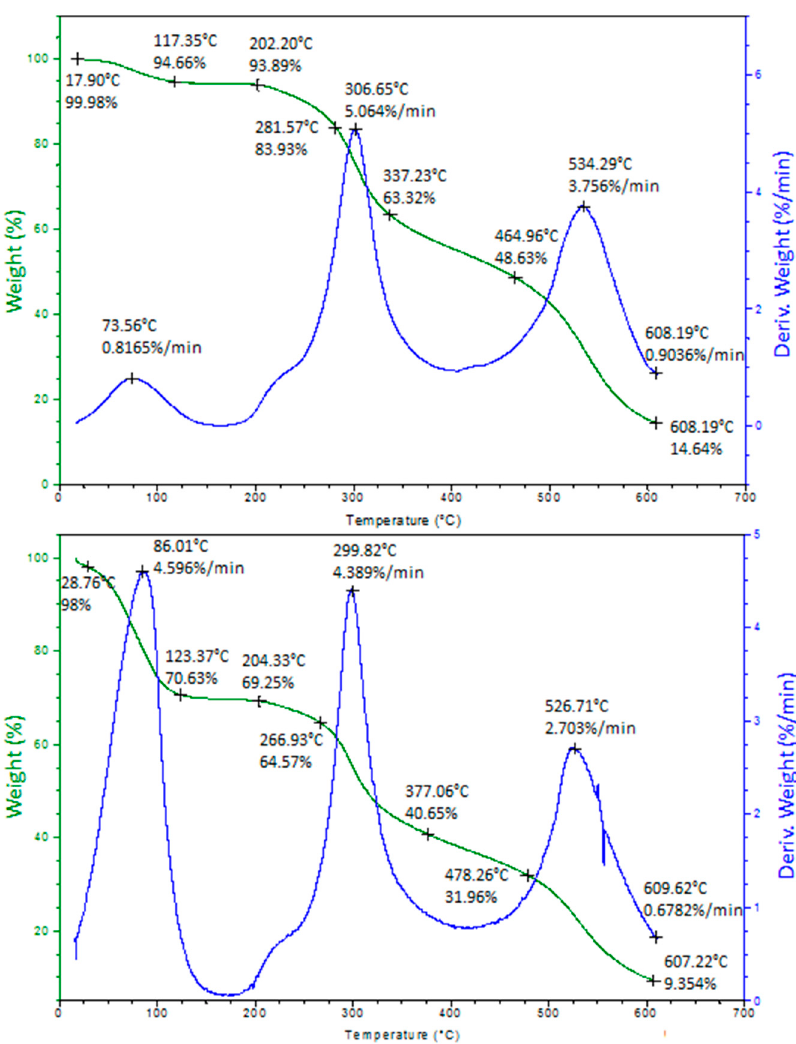
Figure 6. Thermogravimetry and derivative thermogravimetry analysis of silver-casein complexes ( up ) and native casein ( down ) .